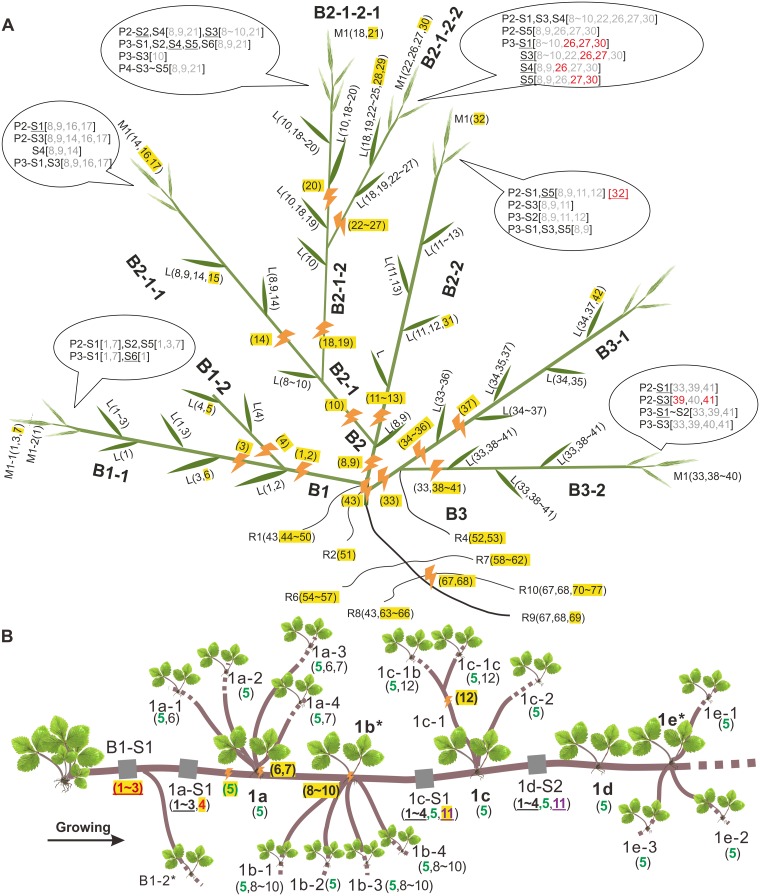
Patterns of somatic mutations in B. distachyon WD2 and woodland strawberry FH1 runners.All mutations are numbered or marked in the same manner as those in Figs 1 and 2. (A) For each branch of B. distachyon, multiple leaves were sampled (marked with abbreviation “L”). The glume/lemma samples (“M”) were carefully collected from one spikelet. For branch B1-1, two glume samples were obtained, with M1-1 from the uppermost of the spikelet and M1-2 from the lowermost part. For other branches, only one glume sample was collected. Root samples (named as R1–R10) were also collected and carefully cleaned for DNA extraction. Seeds (“S”) from another spikelet (“P”) of the same panicle were grown into seedlings to get DNA. For example, two panicles P2 and P3 were collected from branch B1-1, and three seeds (S1, S2, S5) from P2 were used for PCR verification. Fourteen of them, which were also sent for WGS, are marked with underlines. Mutations designed for testing of inheritance are shown in square brackets behind each progeny. A mutation confirmed to be inherited by PCR and Sanger sequencing is marked in red and otherwise in gray. One inherited mutation (32) confirmed by WGS is marked by red and underlined. (B) For woodland strawberry, both leaves (e.g., 1b-1 and 1e-3; for each plantlet, or daughter plant, only a single leaf was sampled) and runner samples (1a-S1, 1c-S1, etc.; gray, each about 15 cm in length) were sequenced. The mutation 5 is colored green to show its wide distribution in all samples sequenced. Samples marked with asterisks (1b, 1e, etc.) were not sequenced because no qualified DNA was obtained. Note that the weight of the approximately 15 cm of runner was about 100–150 mg, which was slightly higher than that of leaf (a single leaf sampled per daughter plant roughly weighed 70–100 mg). The runner DNA is harder to extract, so the total DNA mass from the runner would be a little less than from leaf. However, as usually only around 200 ng of DNA was used in library preparation, the mass of DNA that actually was sequenced should be similar between leaf and runner. WGS, whole-genome sequencing.